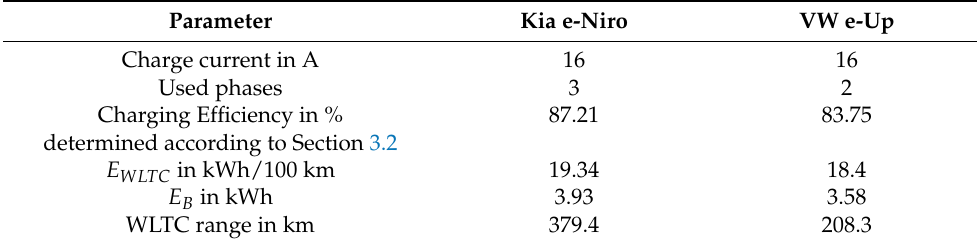
Table 4. WLTP energy consumption with maximal charge